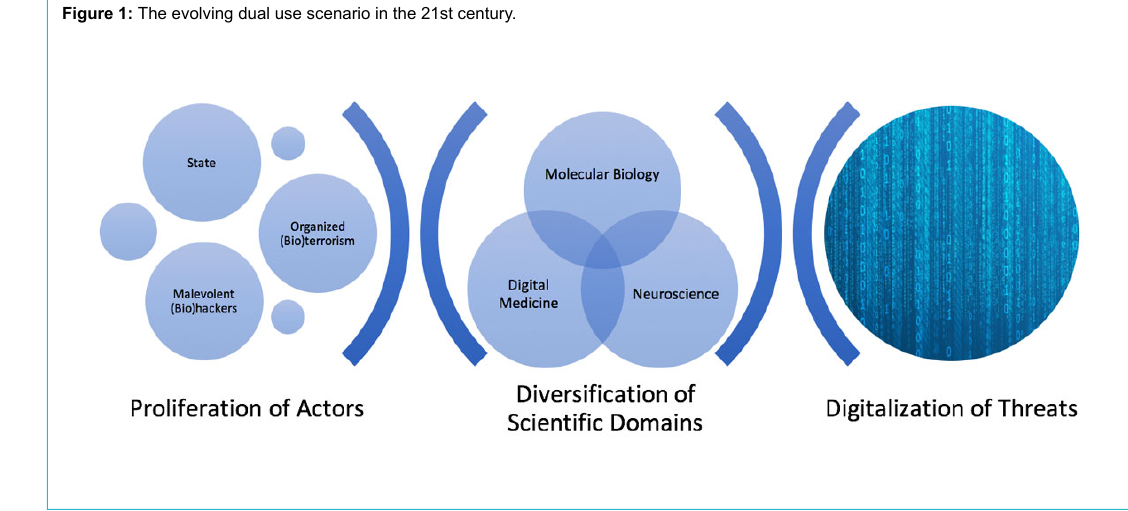
Figure 1: The evolving dual use scenario in the 21st